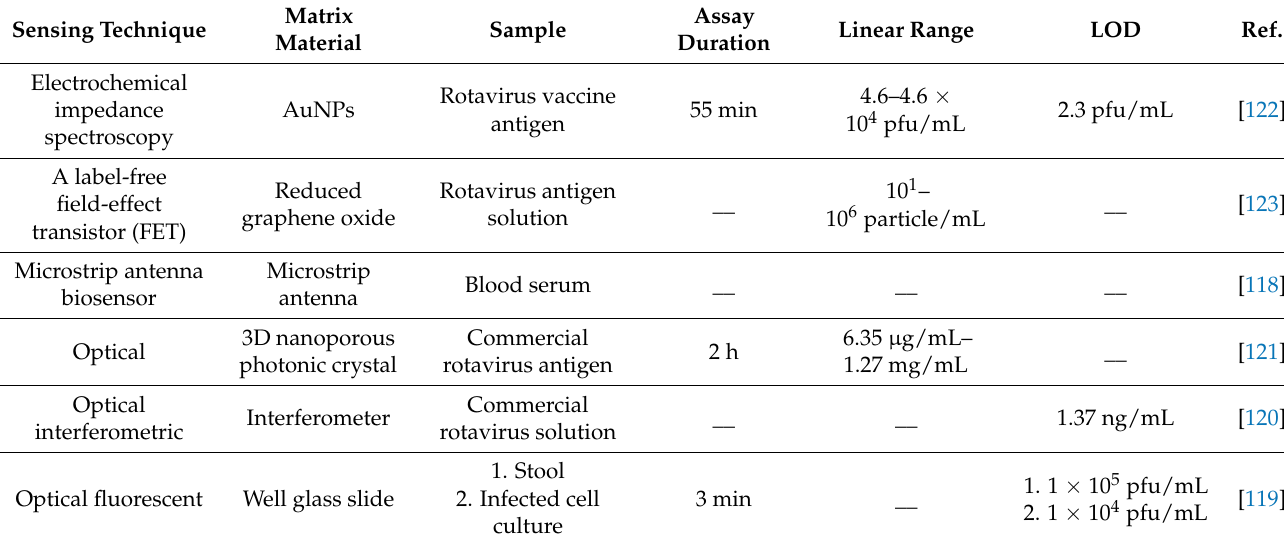
Table 2. The list of various types of biosensors used for rotavirus